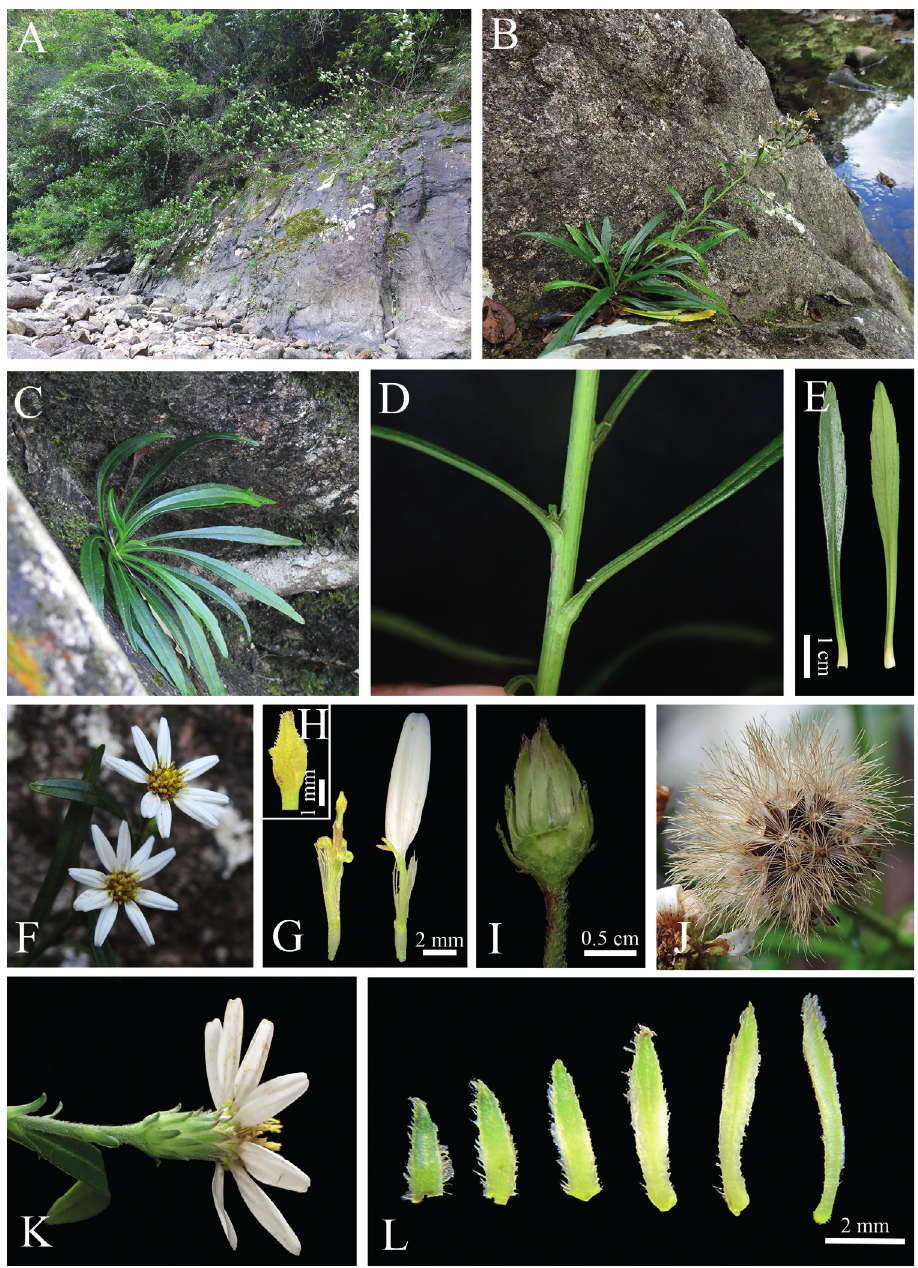
Figure 2. Images of living plants of Aster quanzhouensis A habitat B habit C seedling D steam E rosulate leaves F top view of the capitulum G a disk floret (left) and a ray floret (right) H style branches of a disk floret I receptacle J fruits K dorsal view of a capitulum L phyllaries (from outer to inner, left to